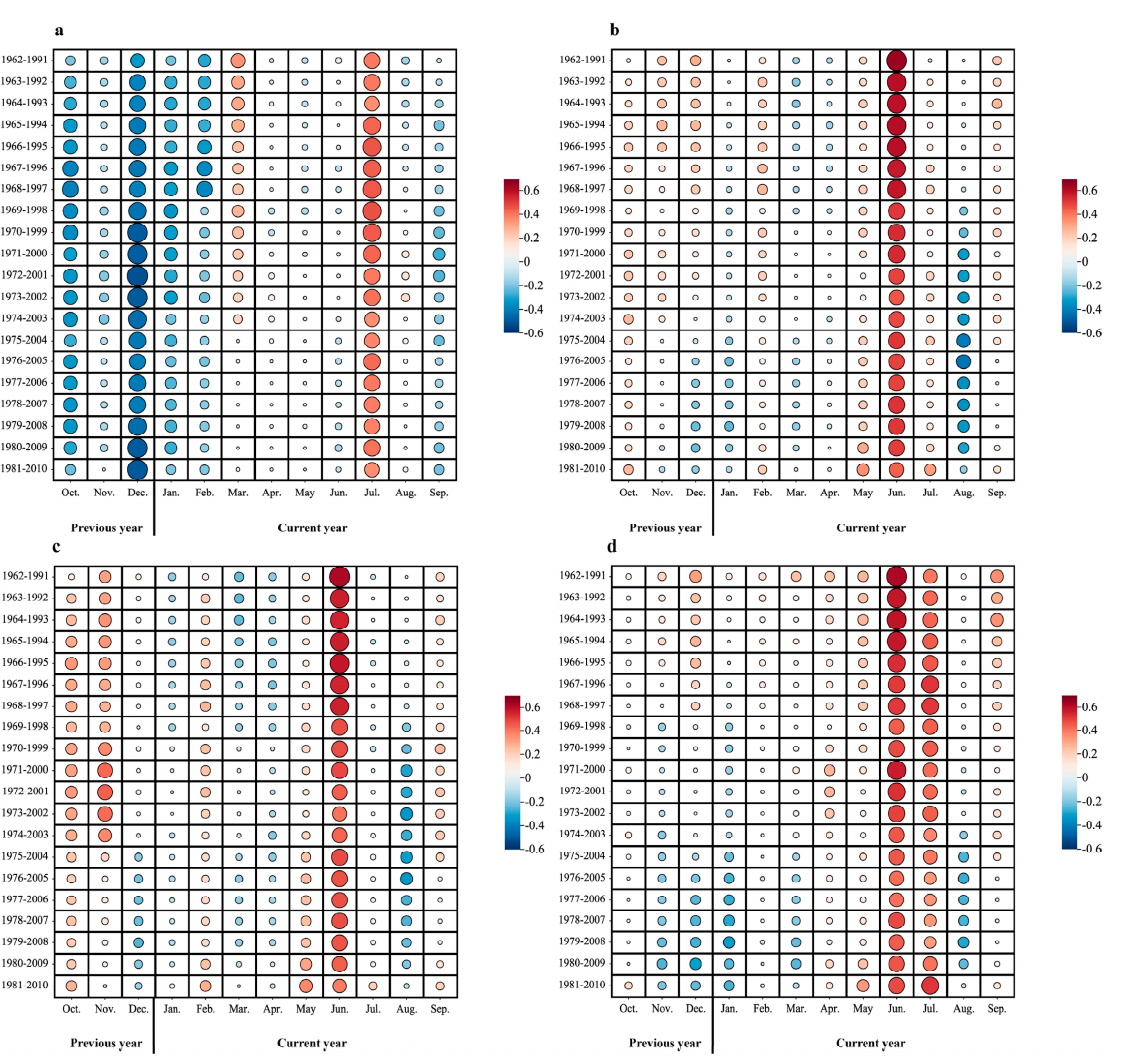
Figure 3. The correlation coefficients between the tree-ring index and climatic factors (PRE, TAVE, TMAX, and TMIN indicate monthly precipitation, mean temperature, maximum temperature, and minimum temperature, respectively).